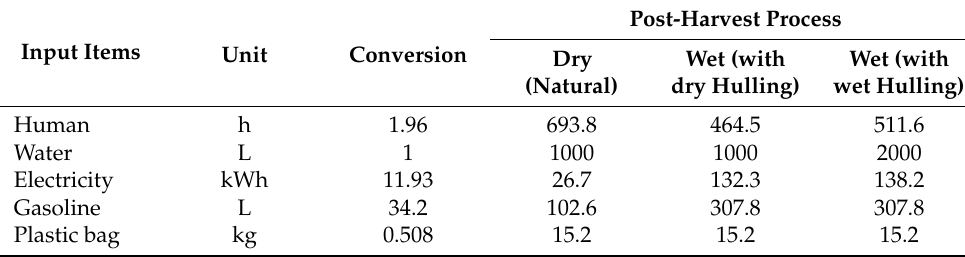
Table A5. Cumulative energy demand for a 1 ton coffee cherry bean process.